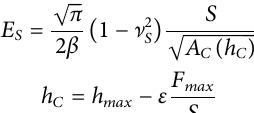
( Figure 1B ). Brie fl y, scaffolds were cast by mixing 250 µl fi brinogen and 250 µl thrombin to achieve fi nal